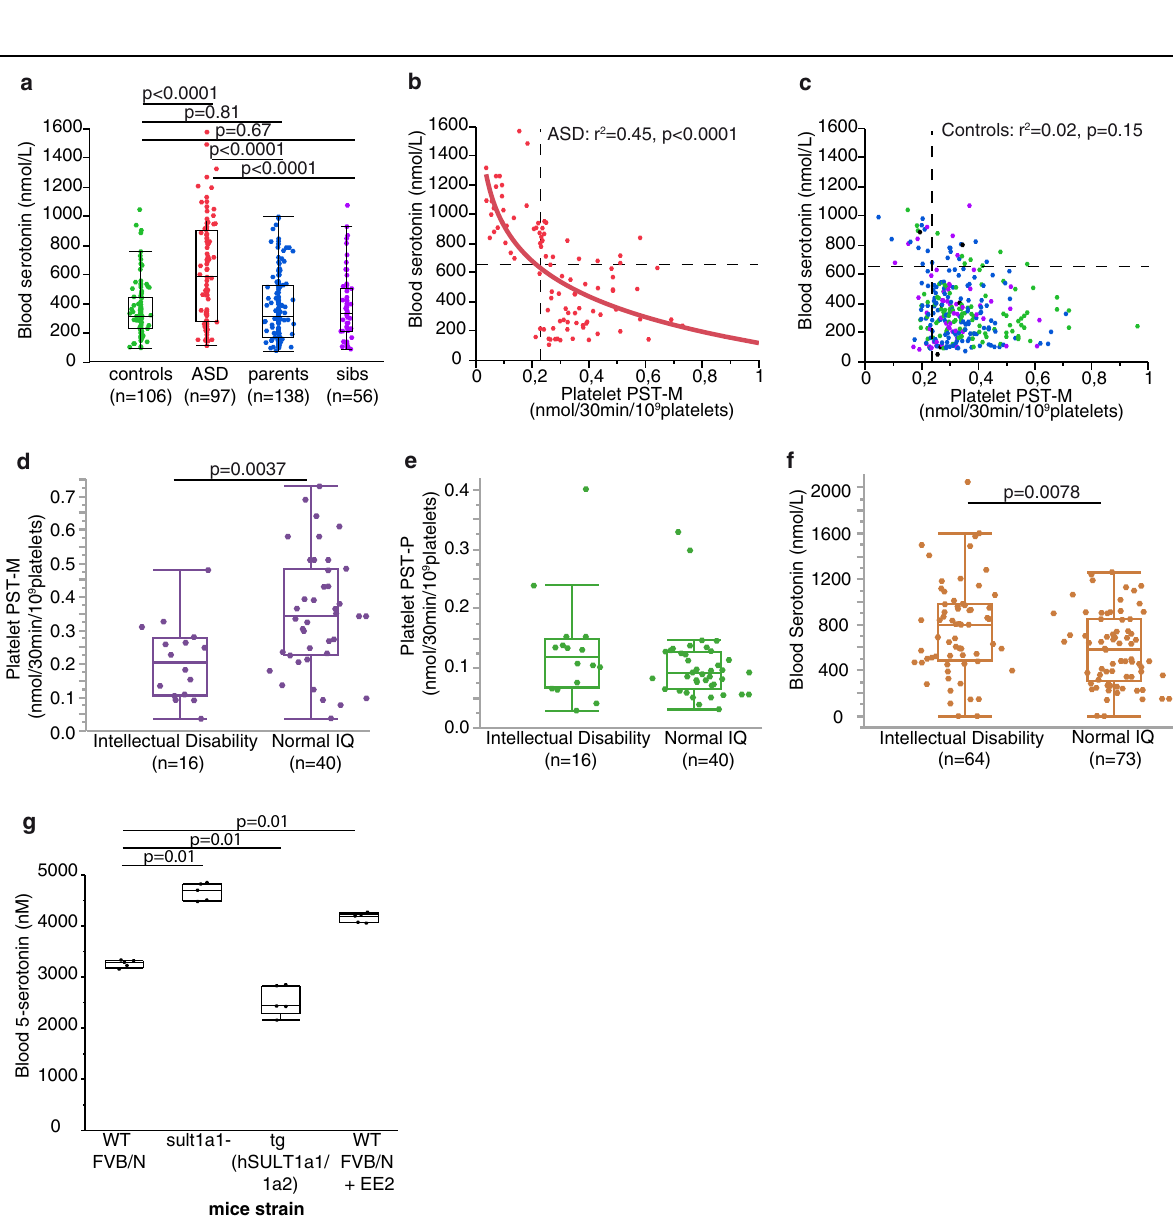
Fig. 3 Relationship between PST activity and whole blood serotonin. a Whole blood serotonin. b , c Correlation between whole-blood serotonin concentration and platelet PST-M activity in b patients with ASD and c their relatives and controls (Pearson ’ s test after log transformation). d – f Platelet PST-M and PST-P activities and blood serotonin according to intellectual disability de fi ned as verbal and performance IQ < 70. g Blood serotonin measured in wild type FVB/N mice (WT), in mice knockout for sult1a1 gene (sult1a1 − ), in mice transgenic for human SULT1A (tg hSULT1A1/1A2) and in wild-type FVB/N mice treated with 17 α -ethinylestradiol (WT FVB/N + EE2), n = 5 in each group. Boxes indicate medians and quartiles. Groups were compared using the Wilcoxon two-sample